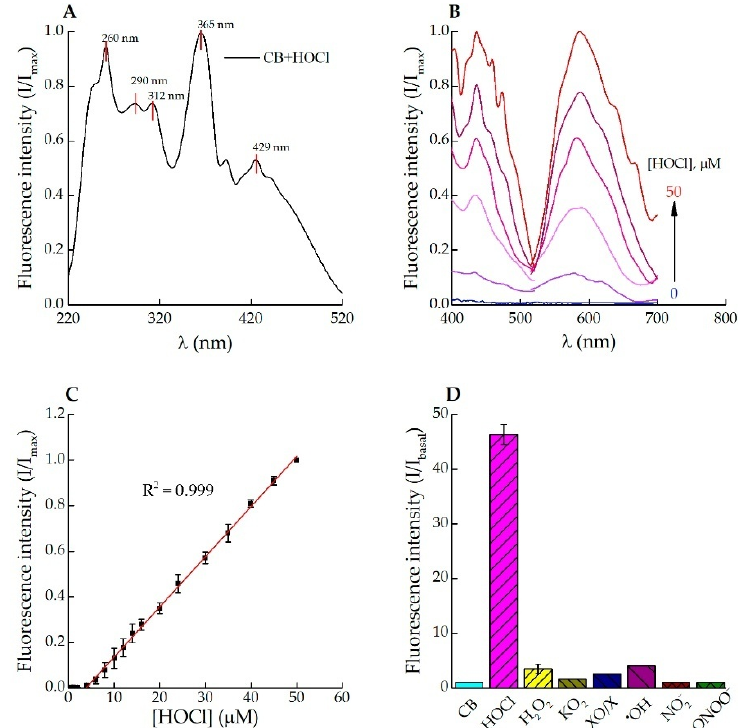
Figure 1. Fluorescence spectra of CB (20 μ M) in the presence of HOCl. ( A ) Full normalized excitation spectra of CB after reaction with 20 μ M HOCl ( λ em = 590 nm); ( B ) Excitation spectra at 400–520 nm ( λ em = 590 nm) and emission spectra at 515–700 nm ( λ ex = 430 nm) of CB in the absence (blue line) and in the presence of 10–50 μ M HOCl (from purple to red lines); ( C ) Fluorescence intensity of CB as the dependence on HOCl concentration in the range of 1 to 50 μ M ( λ ex = 430 nm, λ em = 590 nm); ( D ) Fluorescence responses of CB to HOCl (50 μ M NaOCl), H 2 O 2 (100 μ M), KO 2 (100 μ M), XO/X (140 mg/L XO and 1 mM X), ˙ OH (1 mM FeSO 4 × 7 H 2 O and 100 μ M H 2 O 2 ), NO 2 − (100 μ M NaNO 2 ), ONOO − (100 μ M). All reactions carried out in PBS (pH 7.4), T = 25°C , λ ex = 430 nm, λ em = 590 nm. The results of active MPO detection accomplished 30 min after separating plasma from heparin-stabilized blood incubated with PMA and without the activator at 37 °C for 4 h are demonstrated in Figure 2C.